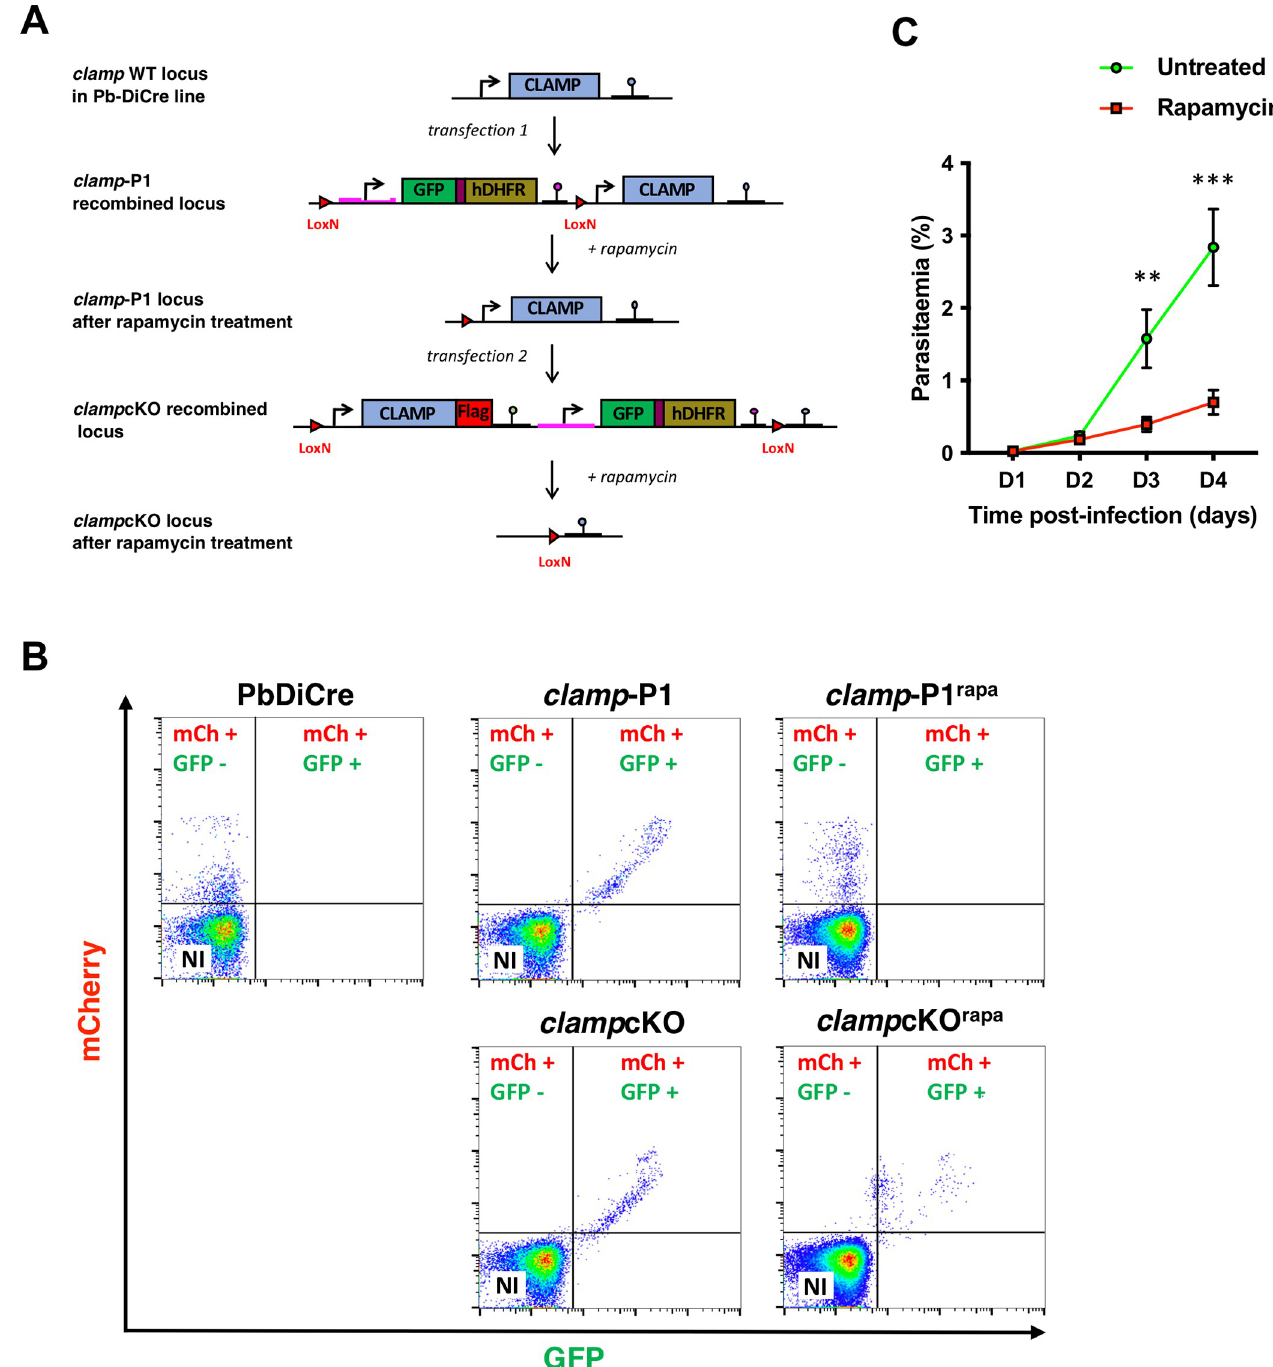
Fig 1. Generation of P . berghei clamp cKO parasites. A. Strategy to modify the clamp locus in the PbDiCre line. A first transfection in PbDiCre parasites with the P1 construct led to the insertion of a GFP-hDHFR expression cassette flanked by two LoxN site upstream of clamp gene. Rapamycin-induced excision of the cassette caused retention of one single LoxN site upstream of clamp in the treated clamp -P1 parasites. In a second step, rapamycin-treated excised clamp -P1 parasites were transfected with the P2 construct to generate a clamp cKO parasite line expressing CLAMP fused to a 3xFlag epitope tag in addition to GFP and hDHFR, and carrying two LoxN sites flanking clamp gene. Rapamycin-induced activation of DiCre leads to excision of the clamp gene together with the GFP- hDHFR cassette. B. Flow cytometry analysis of blood-stage parasites at different steps after initial transfection of the PbDiCre parental line to generate clamp cKO parasites. NI, non-infected red blood cells. C. Blood stage growth of rapamycin-treated and untreated clamp cKO parasites. Rapamycin was administered at day 1. The graph shows the parasitaemia (mean +/- SEM) in groups of 5 mice, as quantified by flow cytometry based on mCherry detection. �� , p < 0.01; ���� , p < 0.0001 (Two-way ANOVA). The experiment shown in panel C was only performed once. https://doi.org/10.1371/journal.ppat.1011261.g001 PLOS Pathogens| https://doi.org/10.1371/journal.ppat.1011261 March 16,